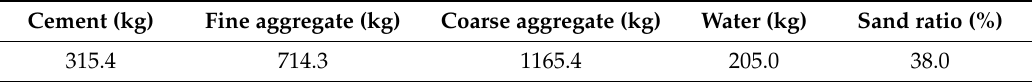
Table 2. Concrete mix proportions.